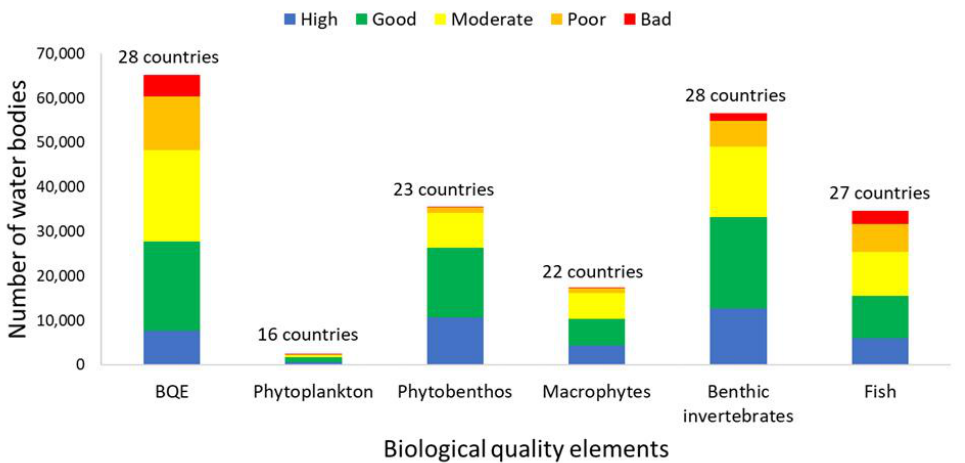
Figure 1. Biological quality elements (BQEs) used in water bodies of European Member States (MS) in accordance with the Water Framework Directive (WFD). Data from one country that uses phytobenthos are not available in WISE Database. Source: WISE Database, 2021.